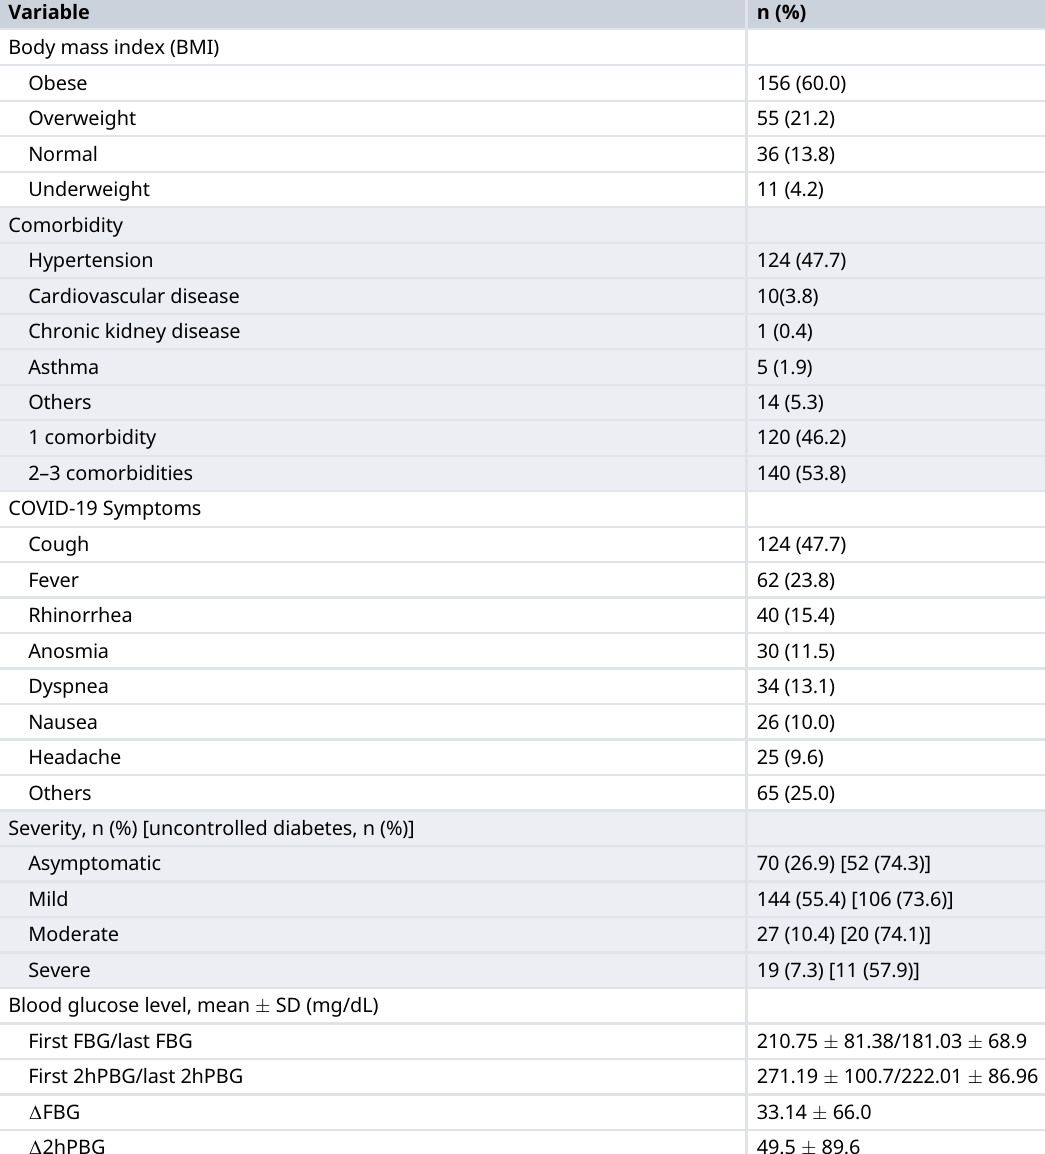
Table 2. Clinical characteristic and blood glucose level of COVID-19 patients with diabetes mellitus (n=260).